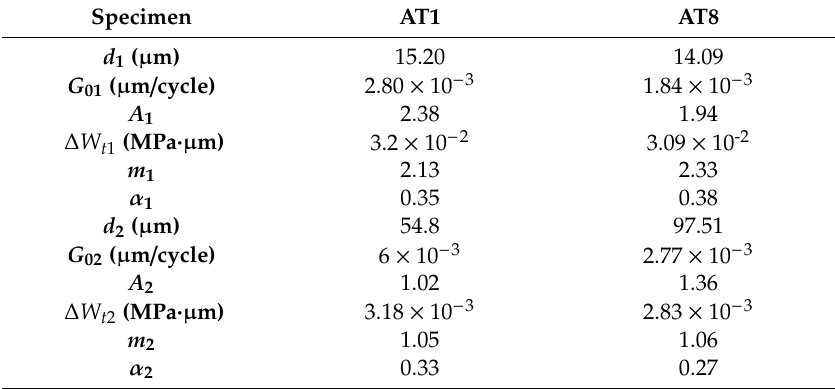
Table 3. Parameters of the multi-axial short fatigue growth rate model for AT1 and